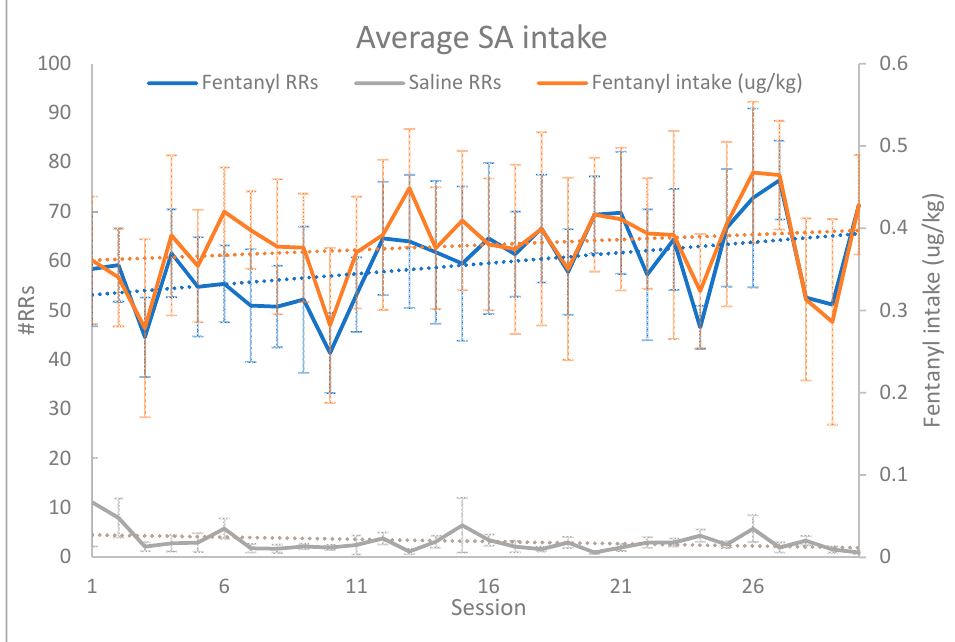
Figure 1. Average SA intake. A simple linear regression revealed that fentanyl animals exhibited escalation of intake over 30 days of SA training as demonstrated by the increased number of fentanyl infusions (RRs; F(1,28) = 16.45, p = 0.0004) and average daily intake of fentanyl (accounting for body weight; μ g/kg; F(1,28) = 9.912, p = 0.0039). Saline animals did not escalate intake over 30 days of SA (F(1,28) = 4.140, p > 0.05). Error bars denote the SEM.